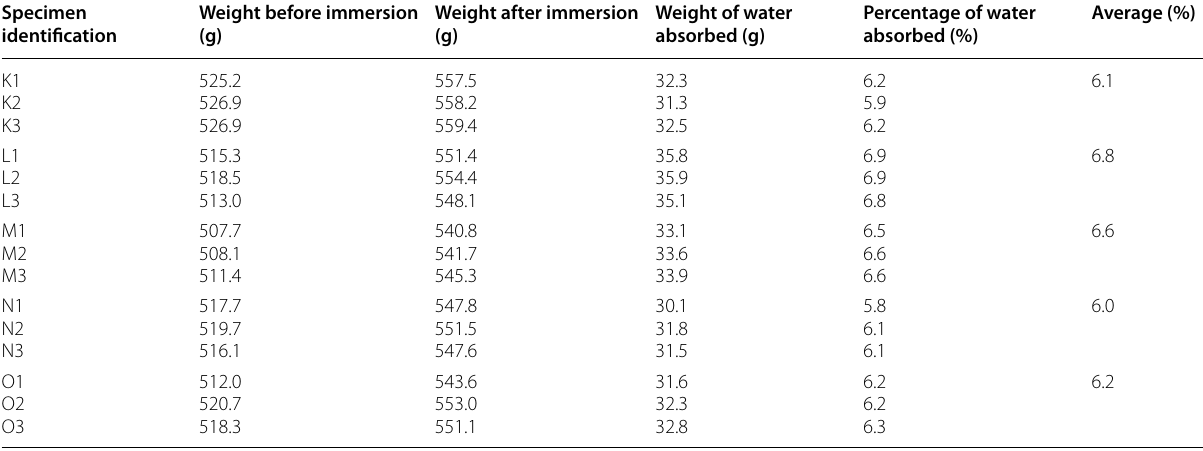
Table 5 Water absorption characteristics of WA cement mortar incorporating